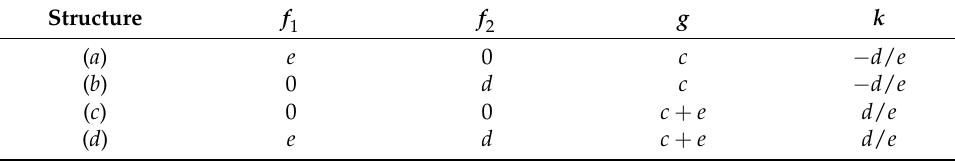
Table 1. Values of triangular–rectangular intermediate